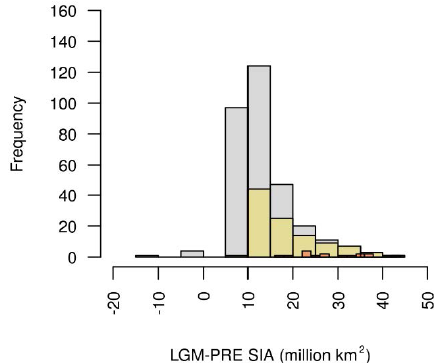
Figure 4. Percentage increase in LGM salinity due to decreasing sea level distribution.